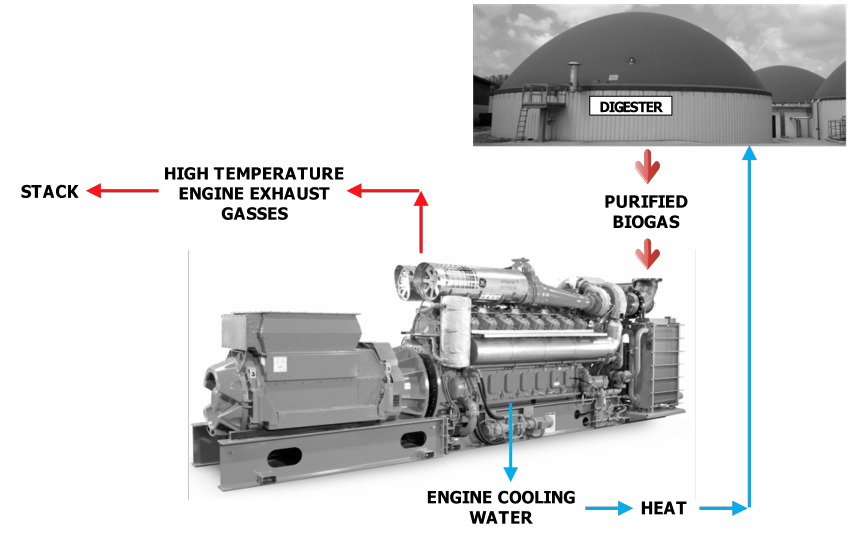
Figure 1. Simplified scheme of a biogas